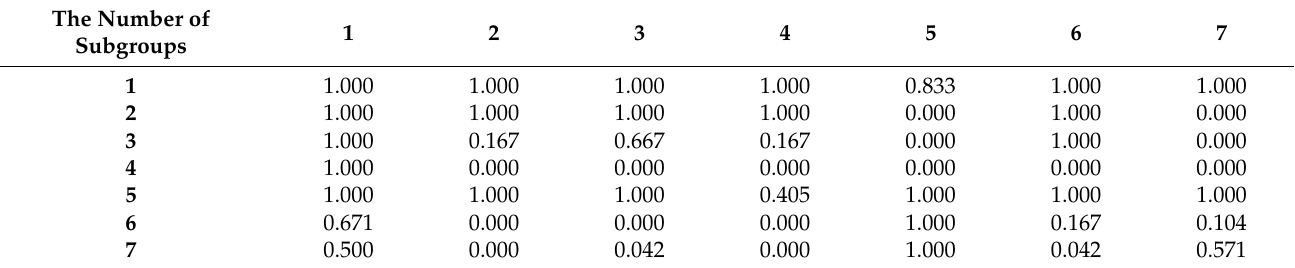
Table 2. Cohesive subgroup density matrix in 2016.